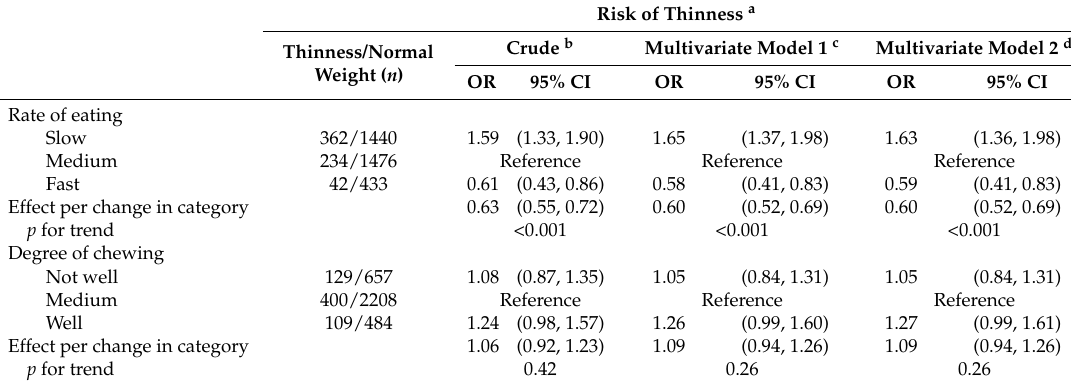
Table 4. Relationship of eating rate and degree of chewing with prevalence of thinness among Japanese preschool